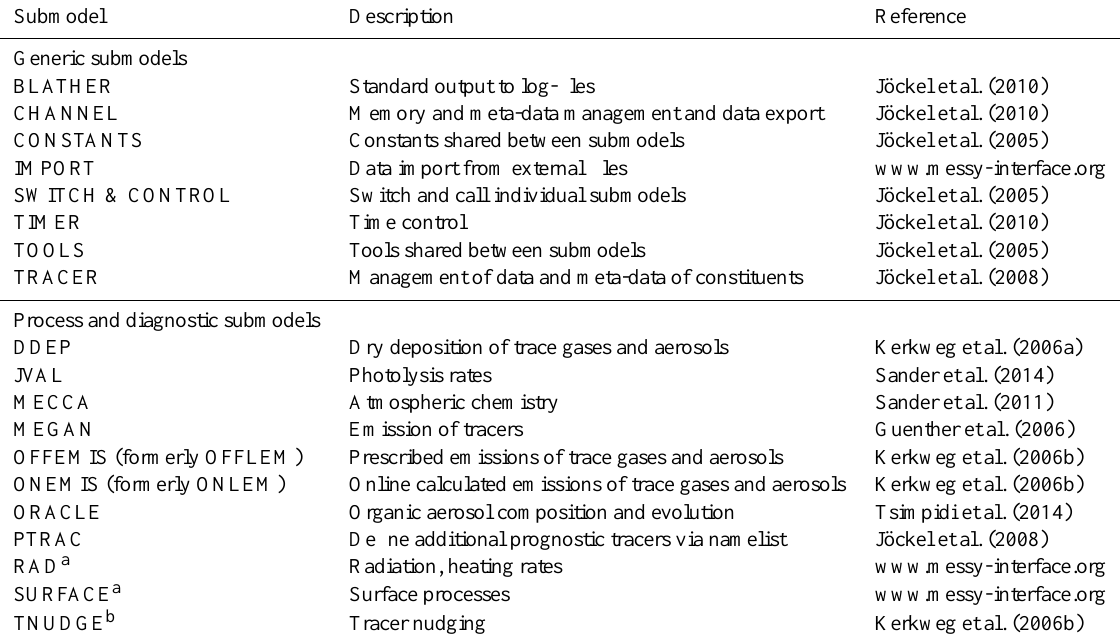
Table 1. List of MESSy submodels coupled with